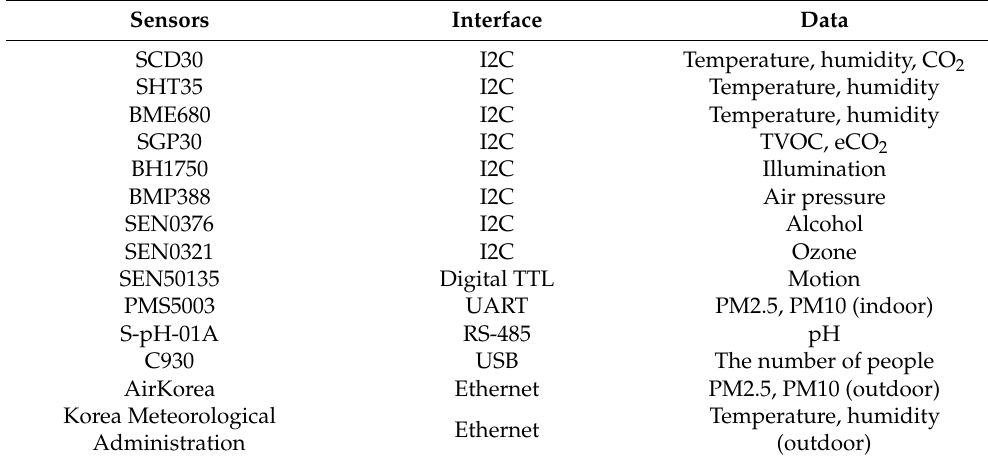
Table 1. Types and details of sensors linked to intelligent multi-environment sensor